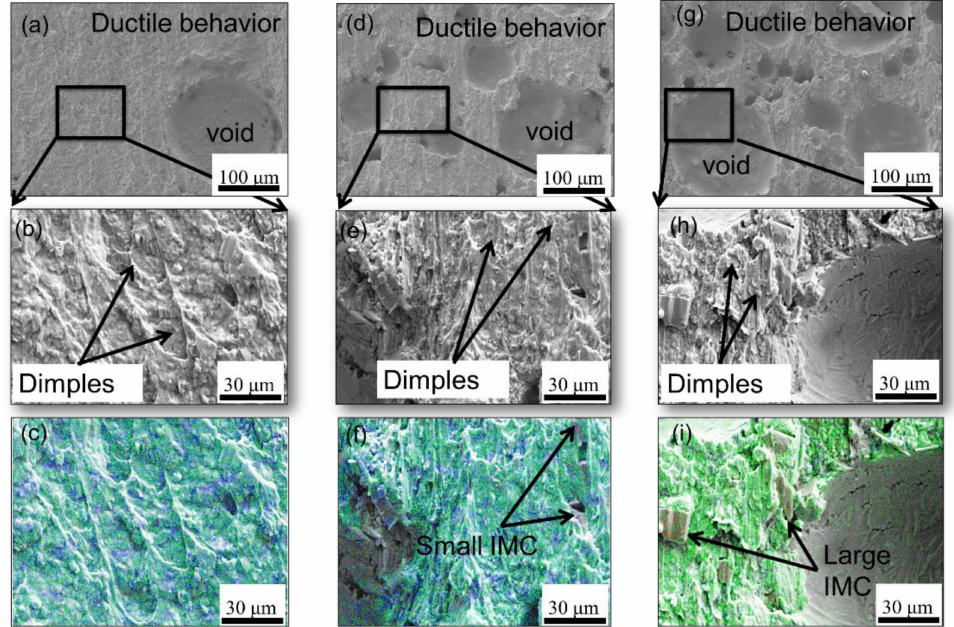
Figure 11. SEM images of the fracture surface of shear test samples: ( a – c ) Cu/IS48/Cu, ( d – f ) Cu/ISC482/Cu, and ( g – i ) Cu/ISC488/Cu